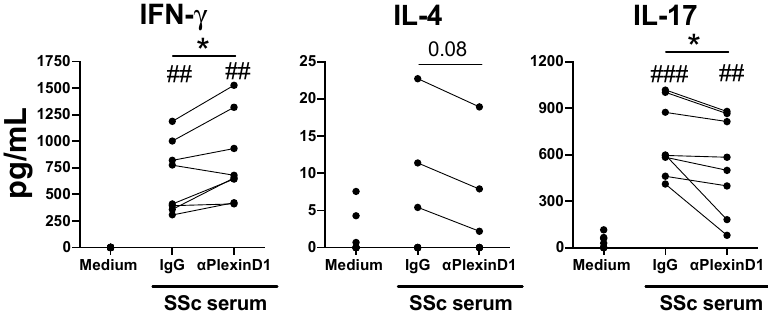
Figure 6. Sema4A-PlexinD1 axis regulates CD4 + T cytokine production induced by systemic sclerosis patient serum. IFN- γ , IL-4 and IL-17 secretion by activated CD4 + T cells, pretreated for 1 h with an anti-PlexinD1 antibody or its respective isotype control (IgG) and incubated with the serum of SSc patients (20% v / v ) for 5 days ( n = 8). Data are presented as connected dots. * p < 0.05. ## p < 0.01 and ### p < 0.001 compared to medium.